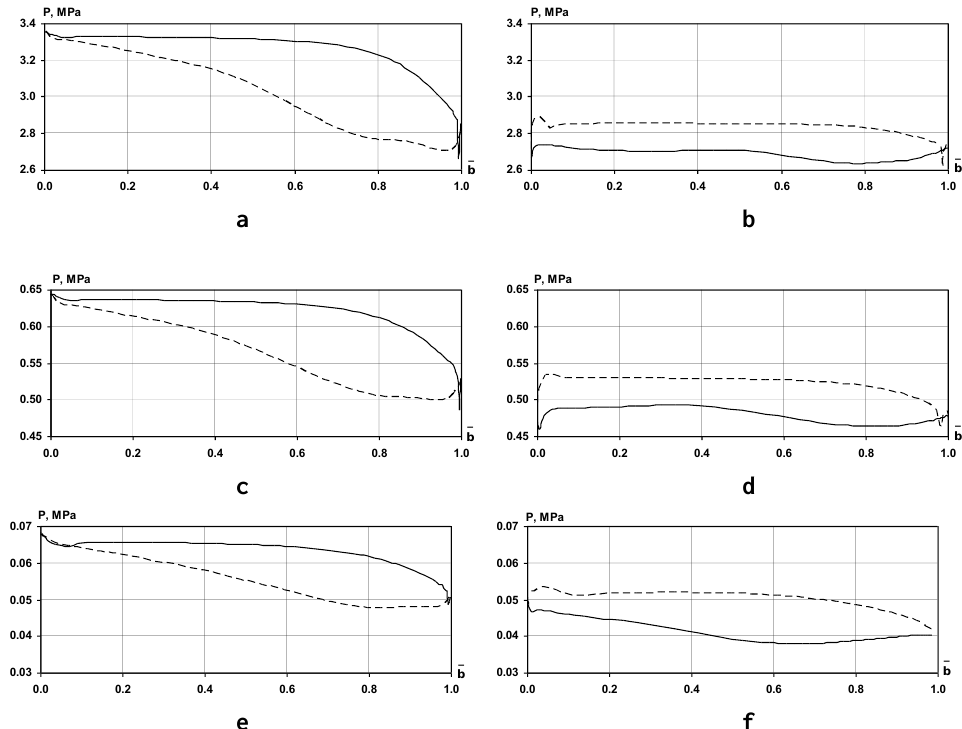
Figure 25. The pressure distribution along the surface profile of the upgraded stators and rotors of turbine CMP T-125/150-12,8: a – S 1st stage; b – R 1st stage; c – S 8th stage; d – R 8th stage; e – S 14th stage; f – R 14th stage • replacement of shroud and interdisc seals to more modern (the expected gain in efficiency of 1.0–1.5%). Figs. 20 and 21 show a view of the new T-125/150-12,8 medium-pressure turbine flow